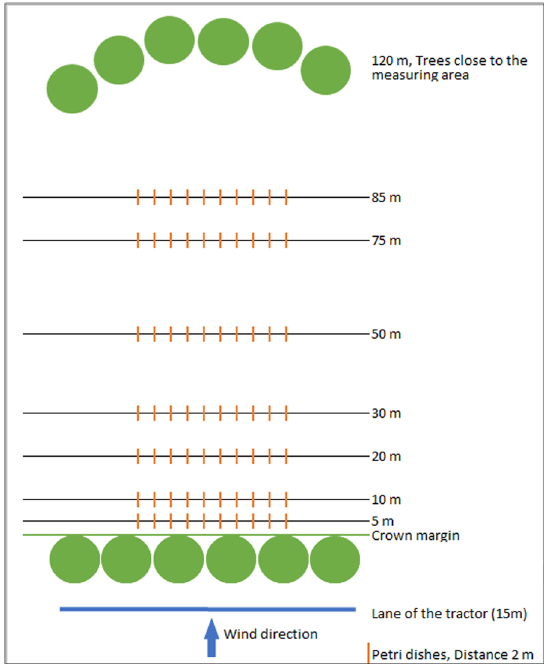
Fig. 2 Schematic figure of the trial area during application, not in